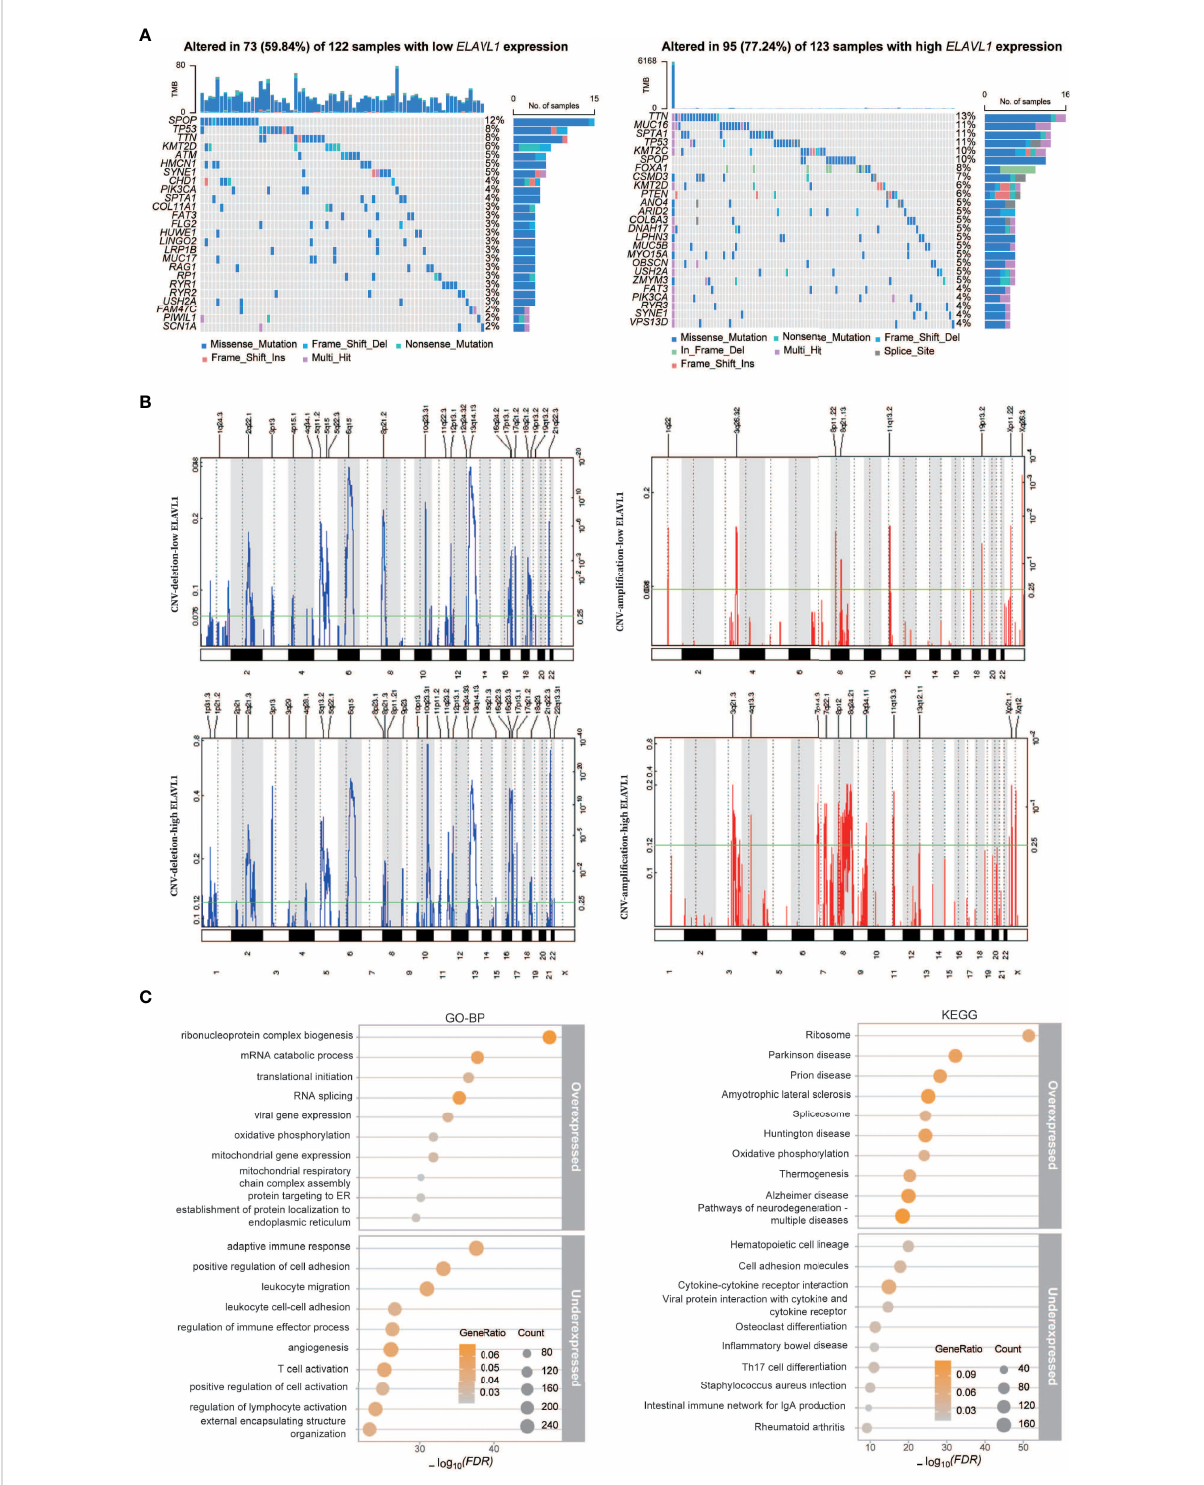
FIGURE 4 Differences in the characteristics of PCa patients with low and high ELAVL1 expression. (A) Landscape of gene mutations in the low-ELAVL1 and high-ELAVL1 groups; (B) GISTIC q-values for deletions and ampli fi cations plotted across the genome; (C) GO-BP and KEGG enrichment analysis of differentially expressed genes between the low and high